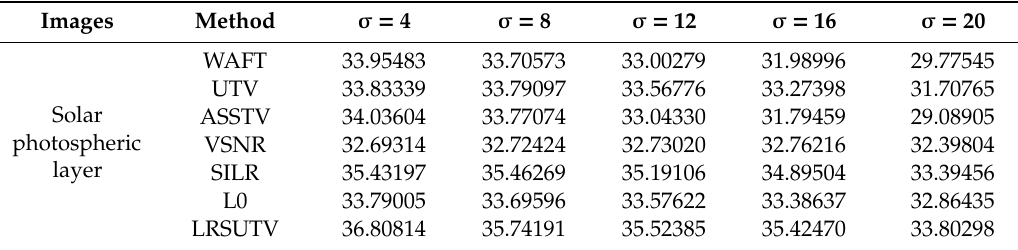
Table 2. PSNR of denoising results of various methods for solar granular. Images